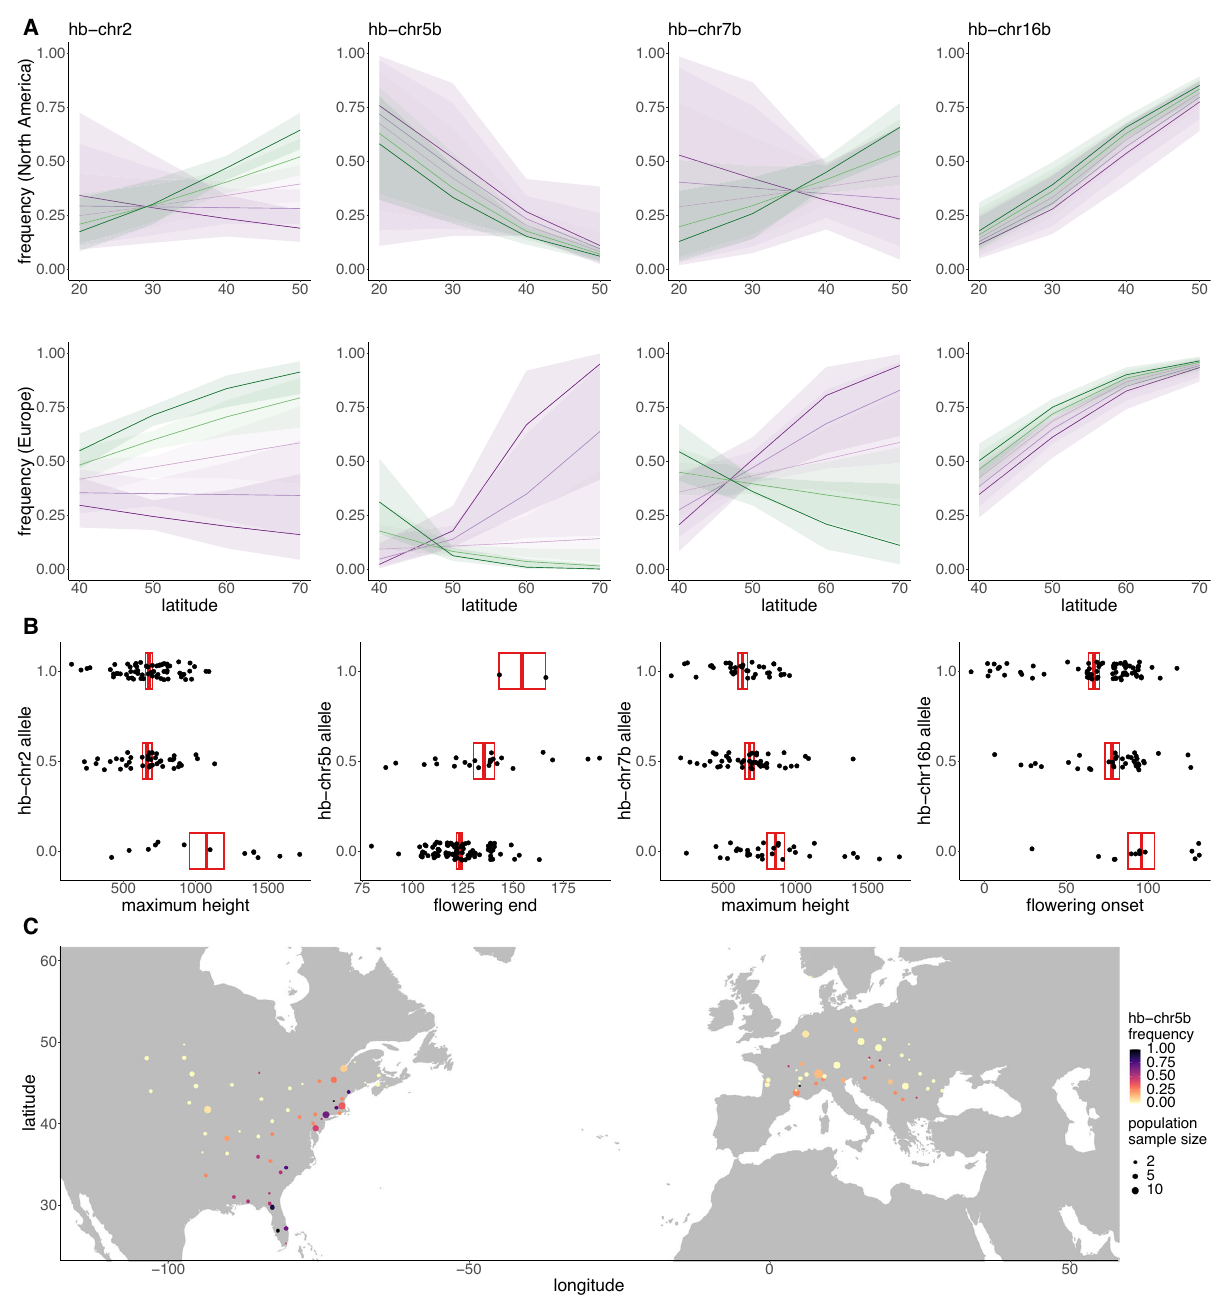
Fig. 5 | Haploblock distributions and trait associations. A Logistic regression models with error bands representing 95% CI of least-squares regressions (see Supplementary Table 9 and Supplementary Data 5 – 9 for model details) of haplo- blockfrequency(allele1)againstlatitudeforfourhaploblocksacross fi vetimebins ranging from most historic (purple) to most modern (green). B Examples of